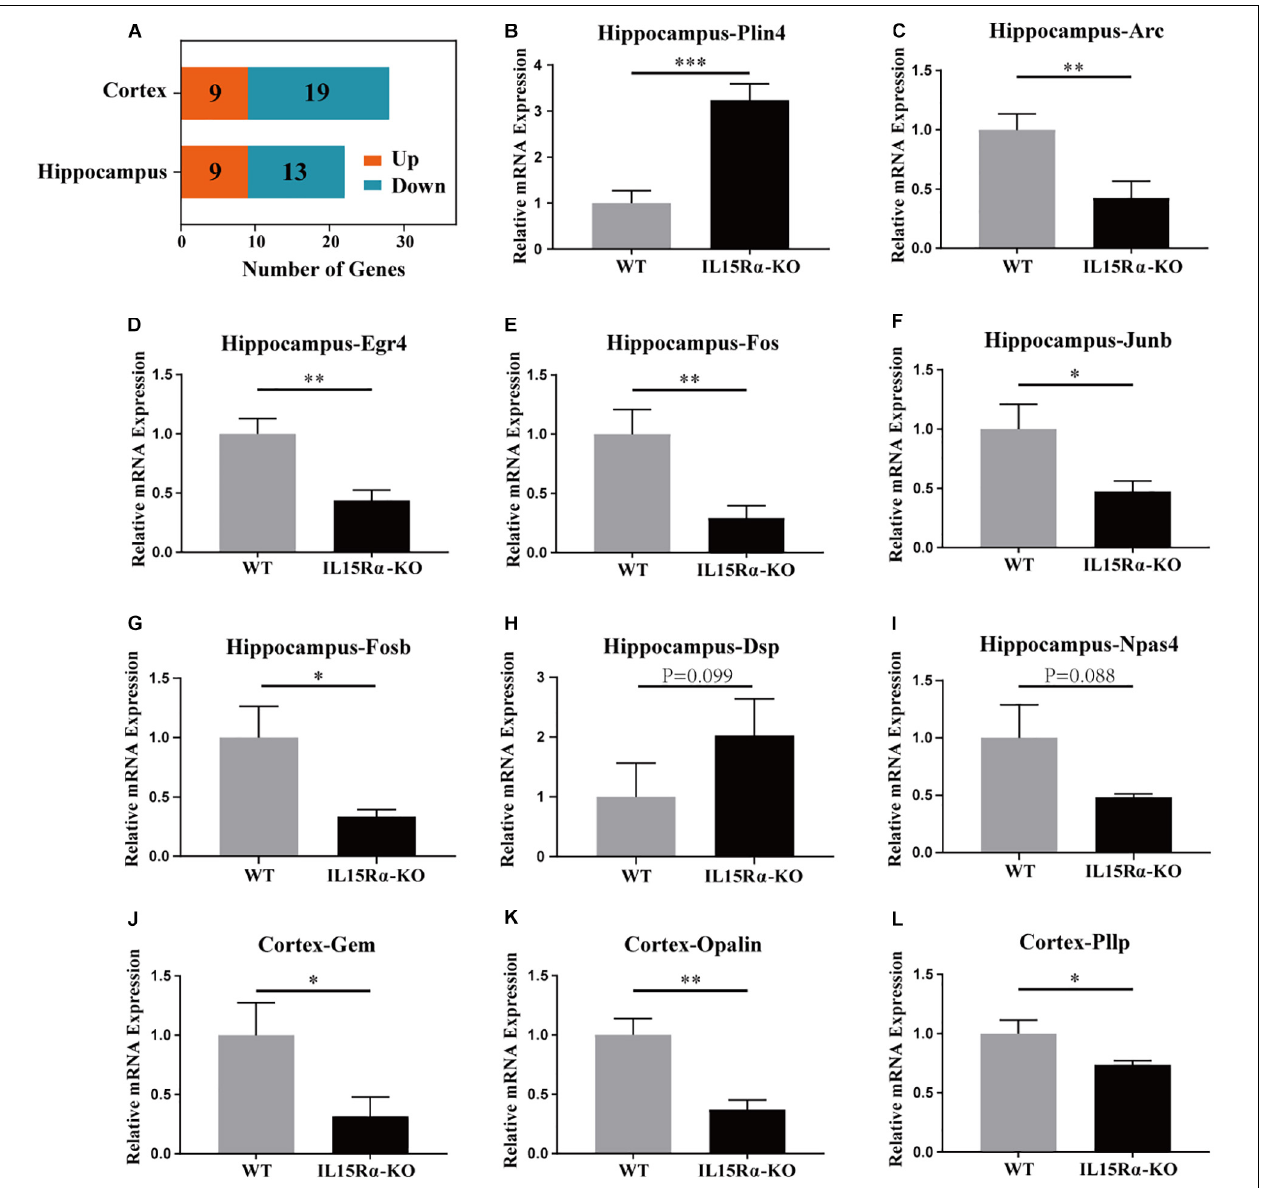
FIGURE 3 | DEG analysis in cortex and hippocampus and qRT-PCR validation of certain DEGs. (A) Stacked diagram reveals the amount of up-/downregulated DEGs in cortex and hippocampus. The genes with absolute value of log2 (fold change) ≥ 1 and p -value < 0.05 between IL15R α − / − group and control group are defined as DEGs. DEGs possessing log2(fold change) > 0 are considered to be significantly upregulated, whereas the other are significantly downregulated. (B–I) Six DEGs ( Plin4 , Arc , Egr4 , Fos , Fosb , and Junb ) in hippocampus are evaluated to be differently expressed between IL15R α − / − group and control group by qRT-PCR. (J–L) Three DEGs ( Gem , Opalin , and Pllp ) in cortex are validated to be differently expressed between IL15R α − / − group and control group by qRT-PCR. Expression is determined by the relative quantification method with β -actin gene as internal reference. Relative mRNA expression is calculated from three biological replicates and depicted as the mean ± SD after normalizing to average expression in control group. The level of significance is calculated by two-tailed unpaired Student’s t -test. * p < 0.05; ** p < 0.01; *** p <